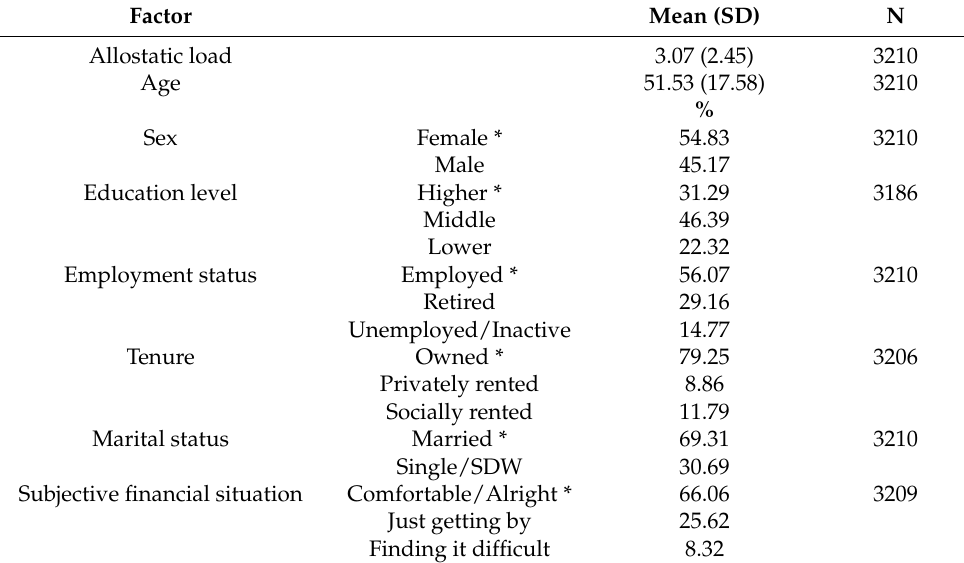
Table 2. Summaries of allostatic load and sociodemographic characteristics from the final wave. Factor Mean (SD) N Allostatic